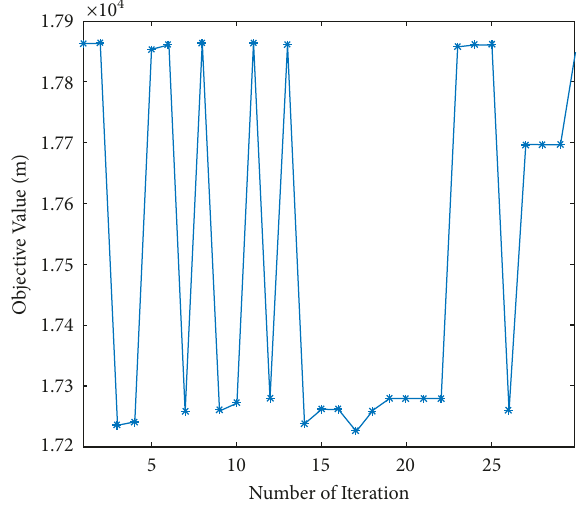
Figure 6: Optical objective value for the repeated running of the